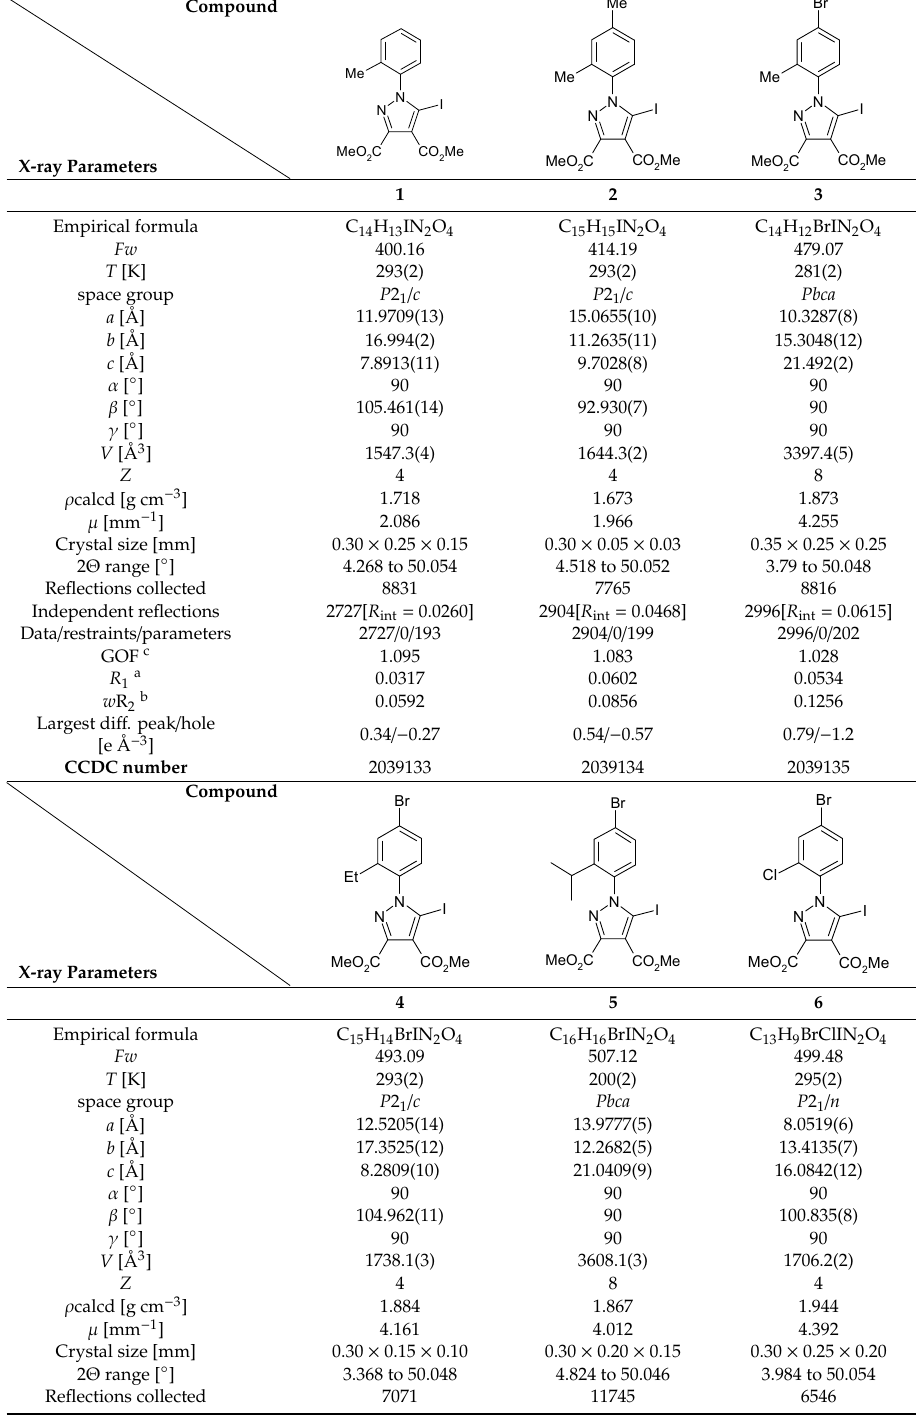
Table 1. The structures of the iodinated pyrazoles 1 – 6 and X-ray diffraction crystal parameters for each compound.